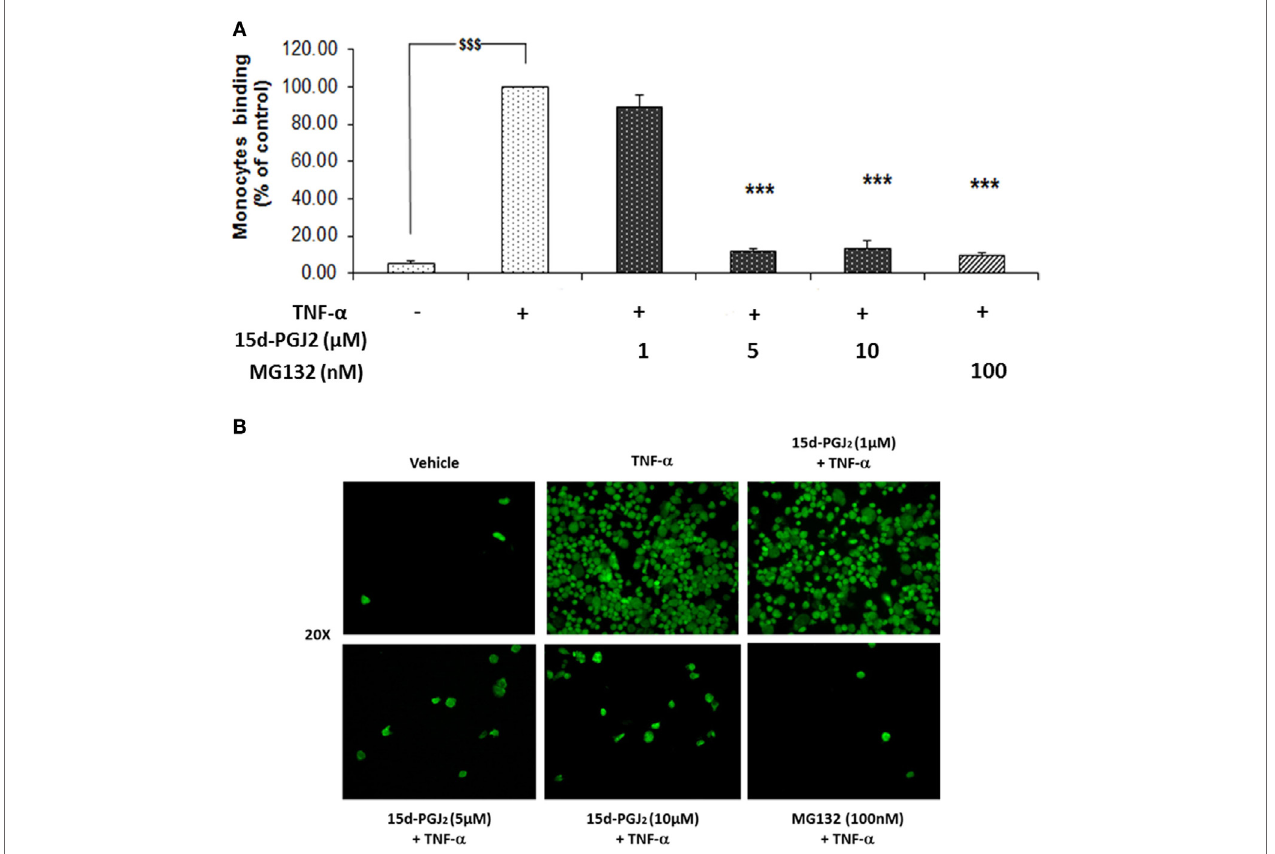
FigUre 5 | 15d-PgJ 2 inhibits human monocyte adhesion to endothelial cells . (a) EC were treated with 15d-PGJ 2 or MG132 for 18 h, followed by 6 h stimulation with TNF- α (0.2 ng/ml), and a static adhesion assay with fluorescence-labeled THP-1 human monocytes was performed. Adherent monocytes were measured in a plate fluorescence reader with 485-nm excitation and 530-nm emission wavelengths. Data were calculated as mean ± SEM of three independent experiments. Data are reported as percentage of TNF- α -activated EC; $$$ ( p < 0.001) vehicle (ethanol) vs. TNF- α ; *** p < 0.001 treatments vs. TNF- α . (B) Representative fluorescence microscopy photomicrographs of monocyte adhesion to EC are